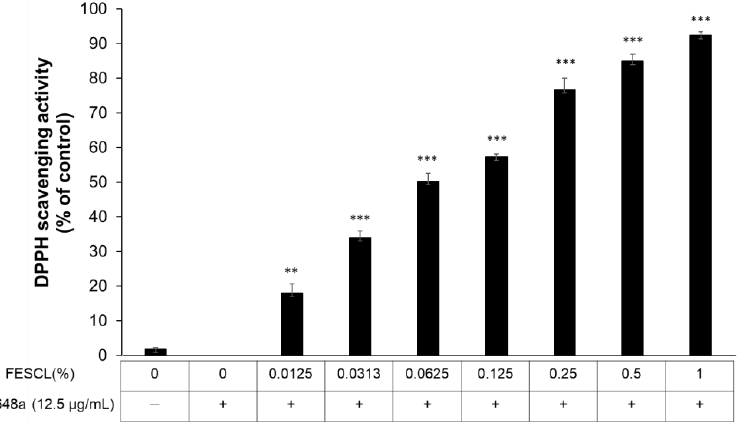
Figure 3. The DPPH radical scavenging activity of various concentrations of FESCL in HaCaT cells by treatment of PM1648a (12.5 µ g/mL). All data were reported as the mean ± SD of three replicates. ** p < 0.01 and *** p < 0.001 vs. the PM1648a treated control group. DPPH; 2,2-diphenyl-1- picrylhydrazyl.